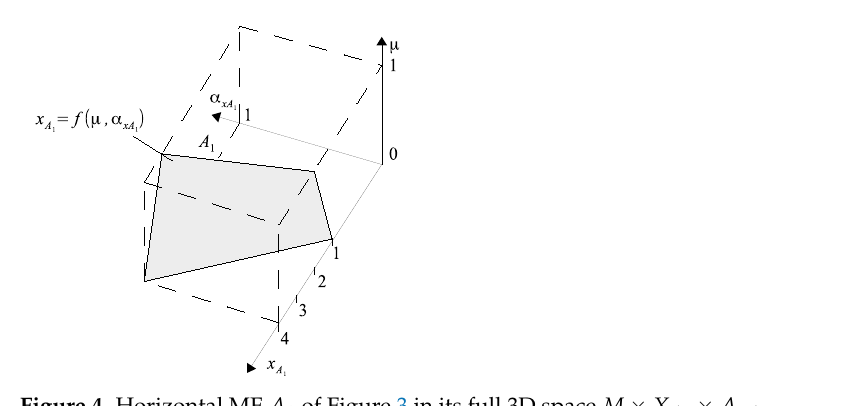
× A Figure 4. Horizontal MF A 1 of Figure 3 in its full 3D space M × X A xA 1 . 1 HMF in Figure 3 models in 2D space the entire surface inside the HMF. The 2D space M × X A is not the full space of this function, but only a subspace, because this function 1 × A exists in the 3D space M × X A xA 1 , as shown in Figure 4. 1